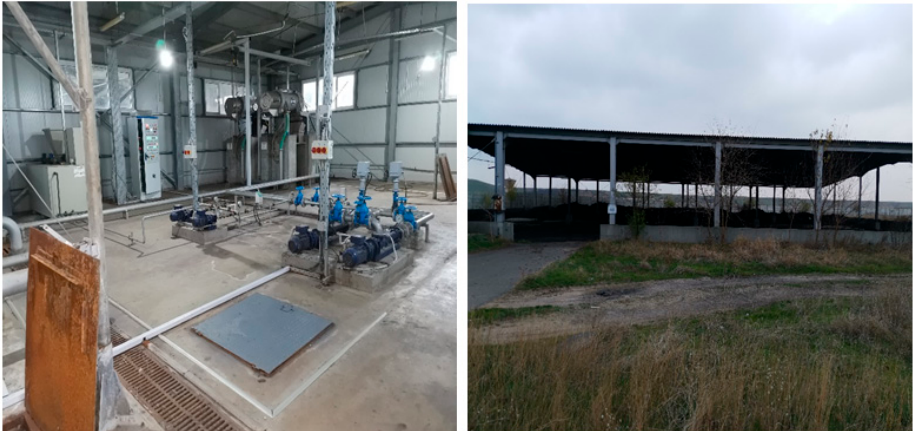
Figure 4. Sewage sludge thickening room (mechanical concentration) and space for the storage of dehydrated sewage sludge.